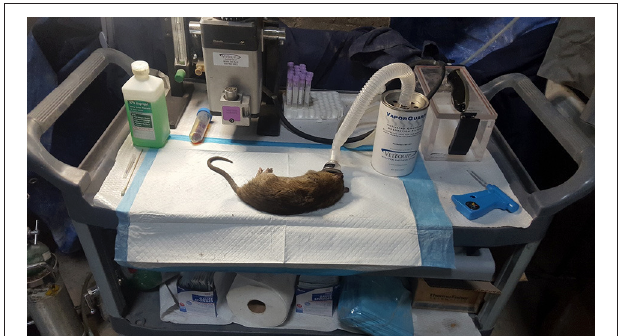
FIGURE 3 | Anaesthetization equipment and typical > 330g rat captured along with ethogram used to score rat behaviors at a semi-enclosed industrial building in New York City from Dec. 27, 2017—May 28, 2018. Rat behaviors scored include walk (w): forward locomotion where animal moves slowly. Run(r): forward locomotion where animal moves at a faster pace, forearms extended. Freeze/stop (f): rats cease activity and become immobile, usually in response to a perceived threat. Drink (d): animal consumes water or other liquid source, usually from puddles. Sniff (s): animal smells object by inhaling air through the nose. Feed (f): animal ingests food particle, often from the floor surface. Sit (s): animal is in relaxed posture, immobile, and may be on haunches with forearms